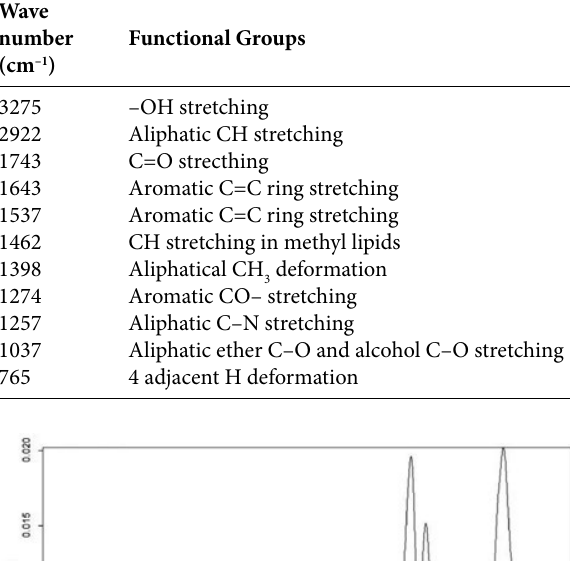
Table 2. FTIR analysis of C. minutissima